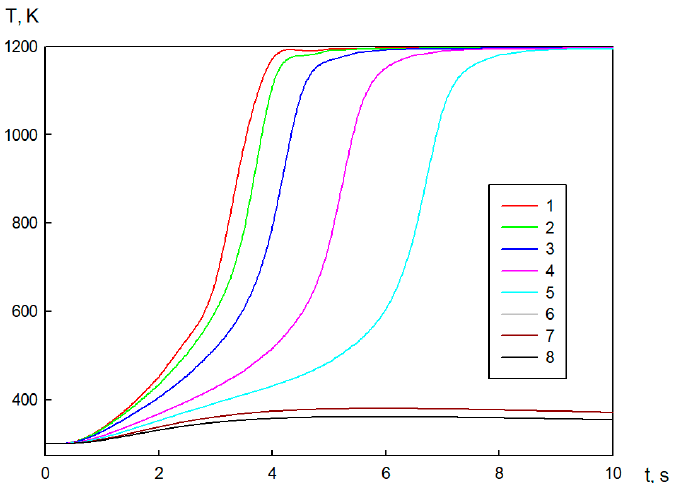
Figure 4. Temperature change over time: ∆ t = 0, d = 15 mm, h = 40 mm, 1—L = 59 mm, 2—L = 49 mm, 3—L = 39 mm, 4—L = 29 mm, 5—L = 26 mm, 6—L = 22 mm, 7—L = 18 mm, 8—L = 14 mm.